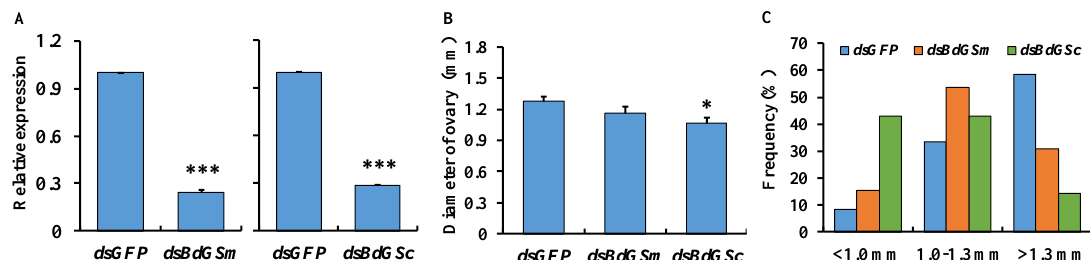
Figure 3. The silencing efficiency for the two BdGSs ( A ), ovarian diameter ( B ), and the frequency of the ovarian size ( C ) after three subsequent double-stranded RNA injections. The gene expression in the control group was calculated and normalized to be 1. The bar represents the mean gene expression, the mean ovarian diameter, and the frequency of ovarian size category ( n = 20). The error bar represents the positive standard error of the mean. The asterisk above the bar indicates the significant difference compared with the control as analyzed by Student’s t -test using SPSS 19.0 (* P < 0.05; *** P < 0.001). The bars in panel C represent the frequency of ovarian size of each category.